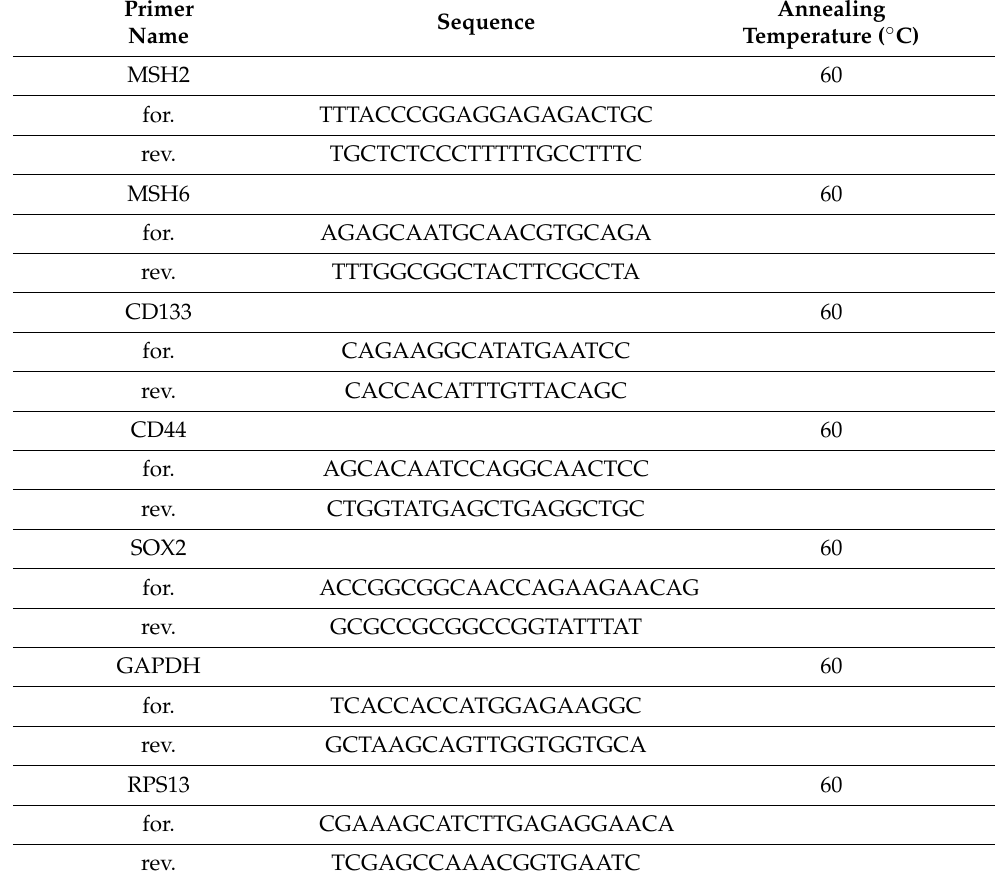
Table 1. Relative expression level was calculated by the 2 − a reference gene, GAPDH or RPS13. Table 1. Primer sequences and annealing temperatures for real-time reverse-transcription PCR (RT 2